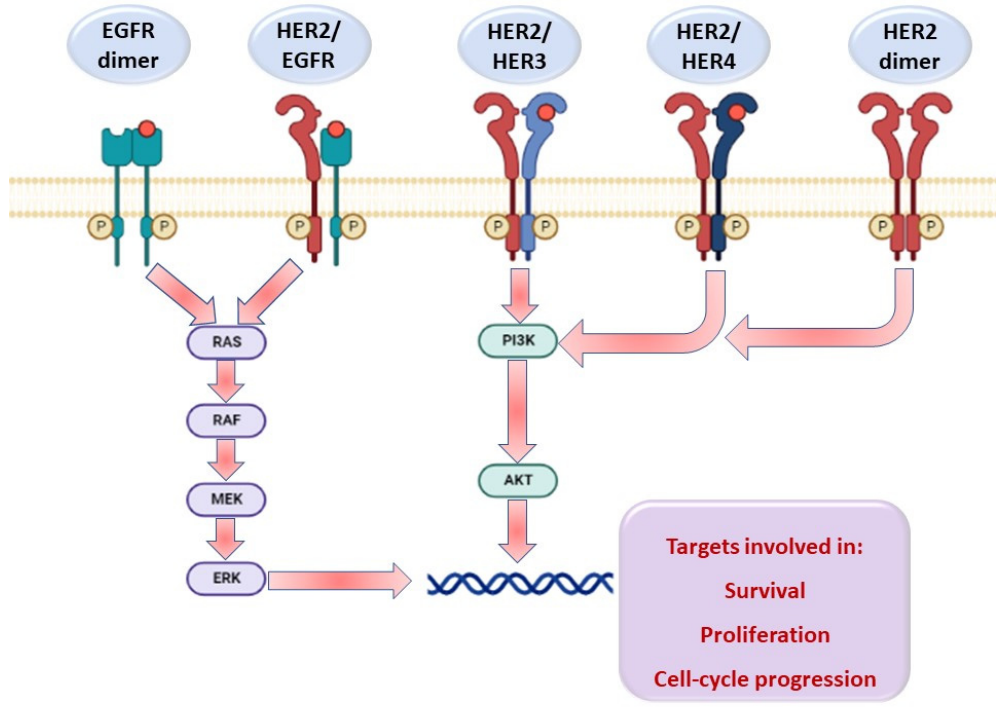
Figure 1. EGF receptors family dimerization mechanism in cell proliferation .